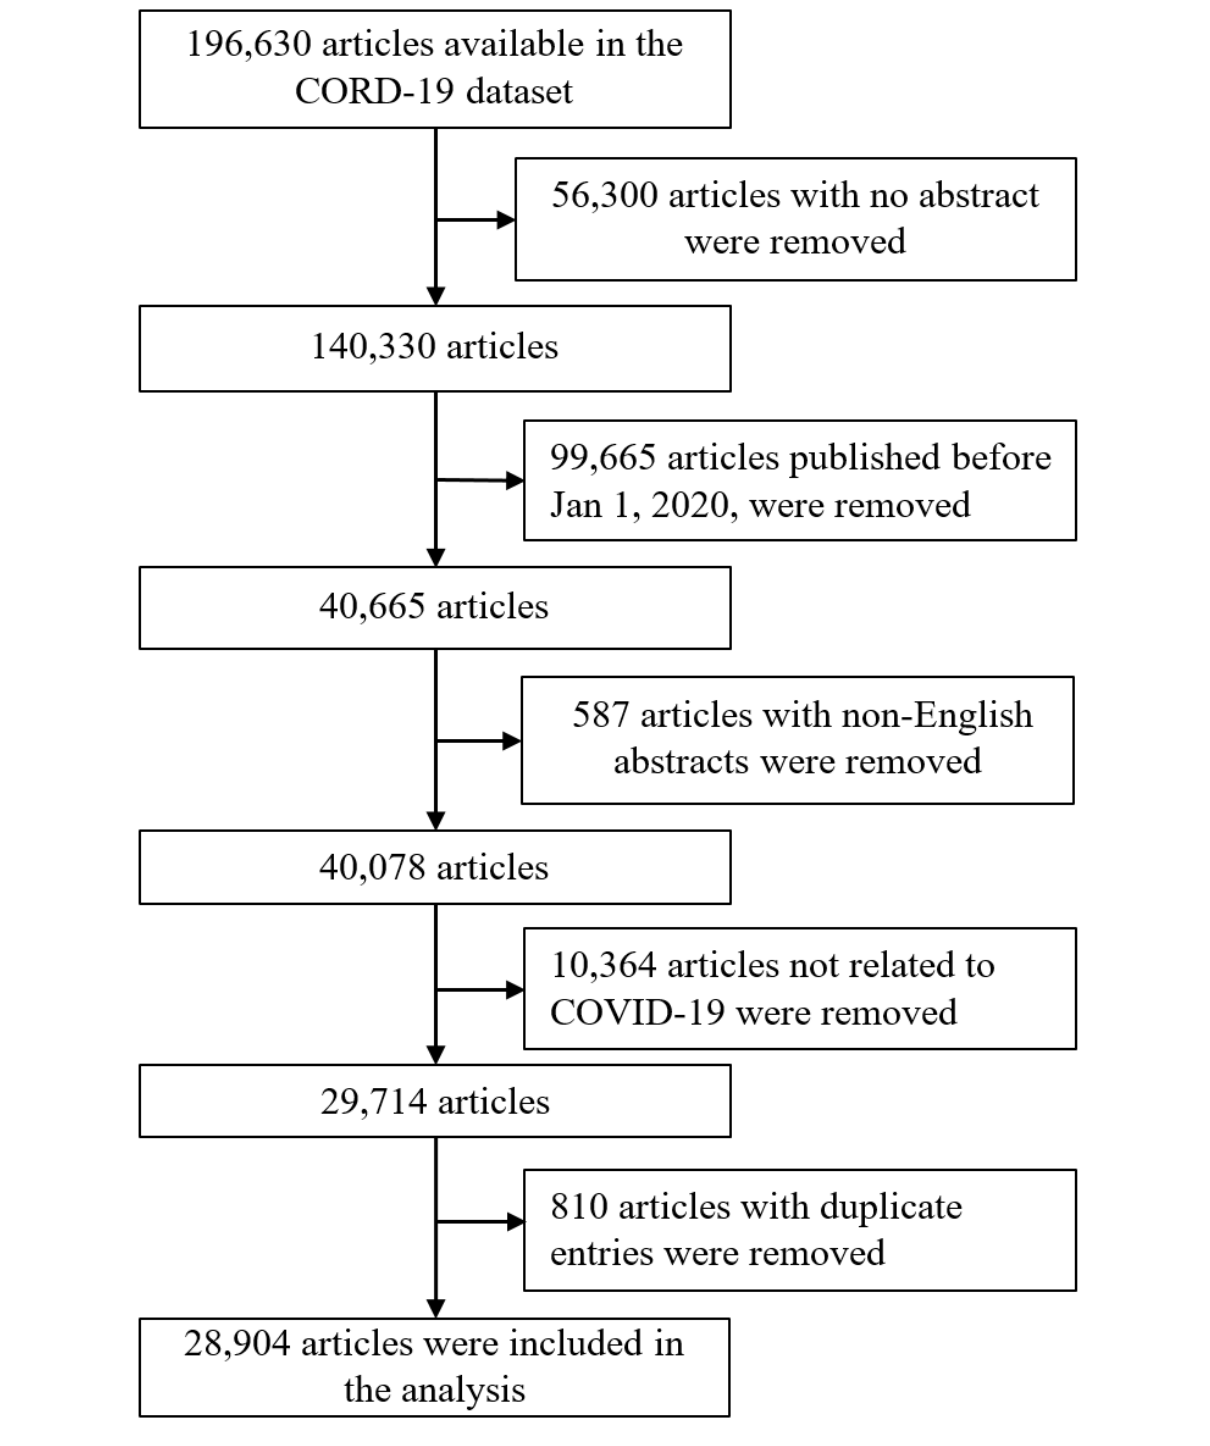
Figure 1. Flowchart of the selection of published articles. CORD-19: COVID-19 Open Research